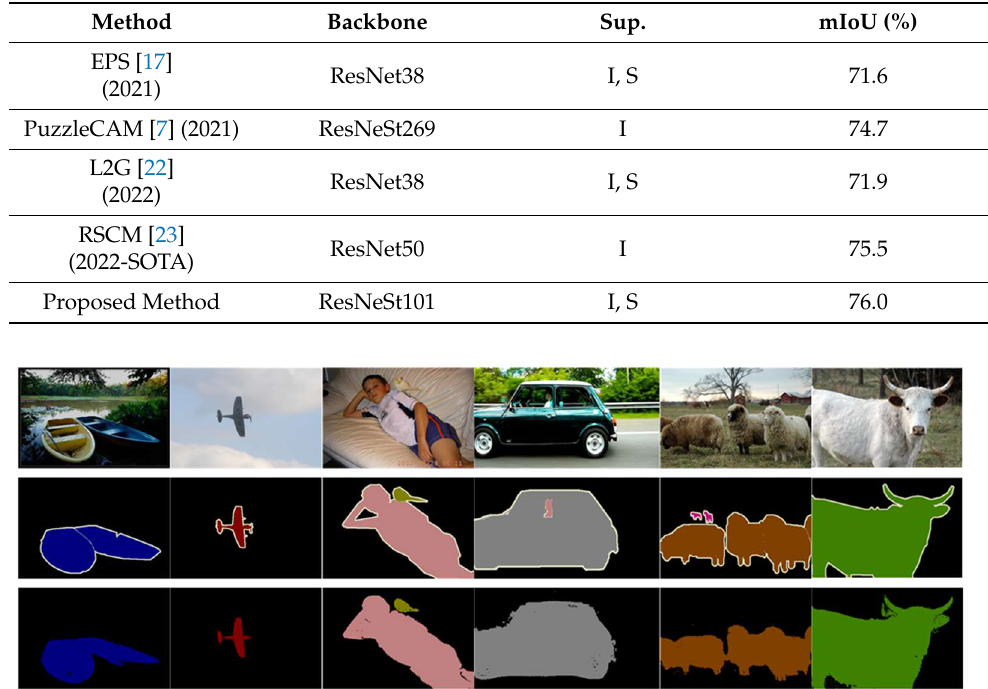
Table 6. Comparison of semantic segmentation results against the state-of-the-art methods with MIOU (%).